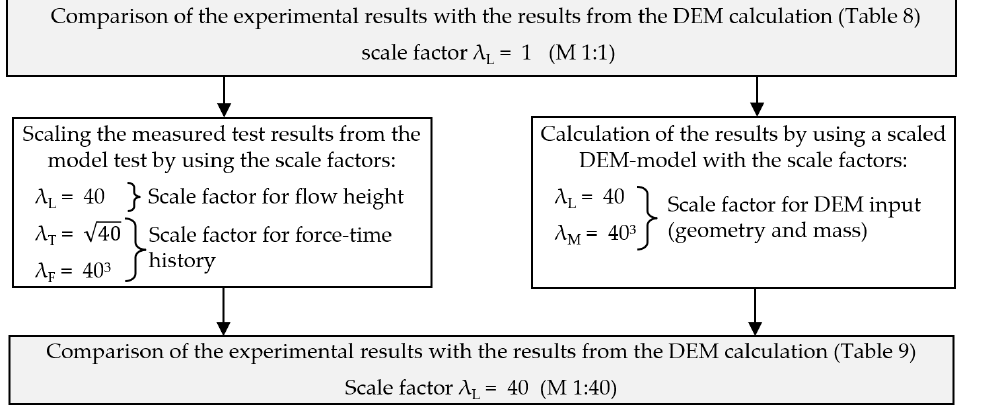
* Calculated values from model test with scale factor, ** Input parameters for the scaled DEM model.